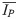
Schematic illustration of a plane polariscope.Where IP¯ is the light entering the birefringent specimen, IS1¯ and IS2¯ are the fast and slow components for light, respectively, as they pass through the specimen, and IA¯ is the observed light passing through the system.